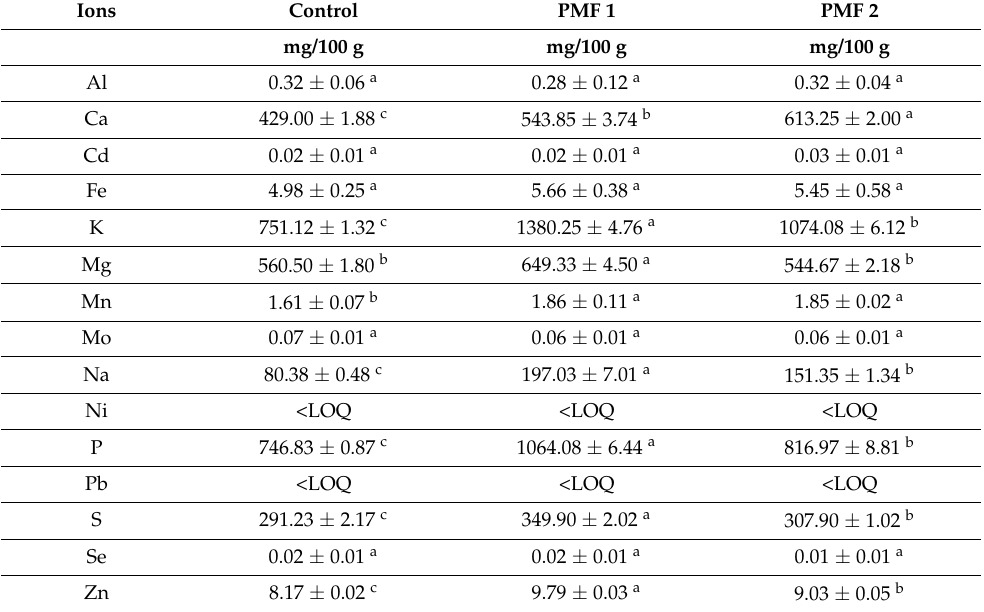
Table 4. Changes in the content of basic micro and macro components and heavy metals under the influence of applied pulsed magnetic fields for sunflower sprouts.